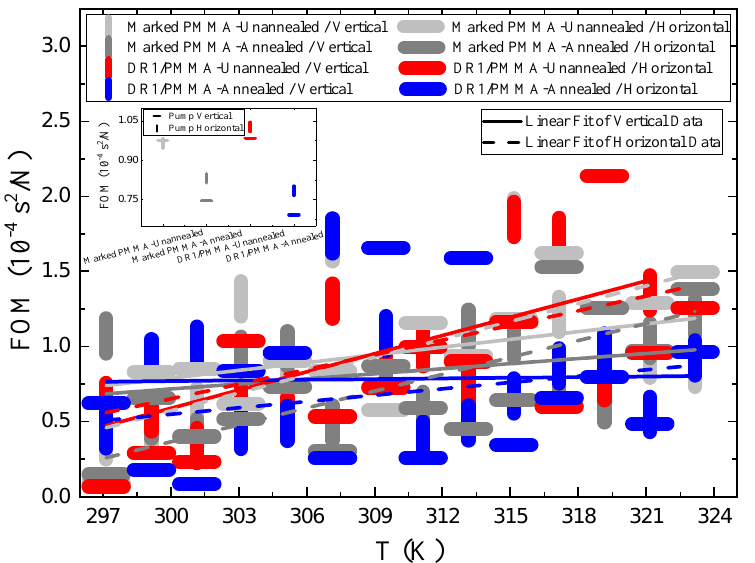
Figure 19. Figure of merit as a function of temperature for PMMA and DR1/PMMA fibers derived using Equation (11). The inset shows the average FOM over all intensities as a function of fiber composition and processing. The lines are fits to each composition and processing